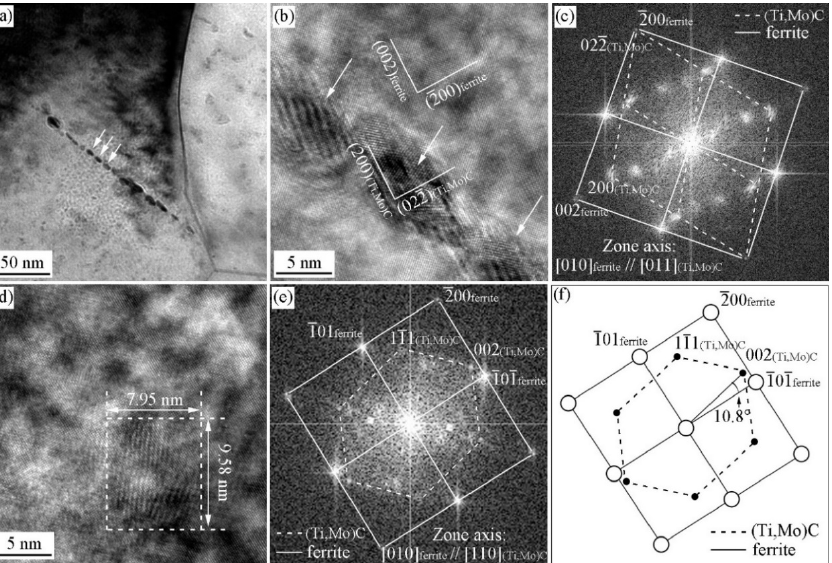
Figure 13. HRTEM image of precipitates and the ORs between the precipitates and ferrite matrix in the Ti-Mo steel produced by process II with the cooling rate of 80 °C/s ( a , b ) TEM and HRTEM im- ages of planer carbides, and the arrow pointing the planer precipitates after grain boundaries mov- ing; ( c ) FFT diffractogram of planer carbides; ( d ) HRTEM image of the supersaturated carbide; ( e ) FFT diffractogram; ( f ) the simulated diffraction pattern of the supersaturated carbide. Figure 14 shows the HRTEM images and the FFT diffractogram of a supersaturated precipitate. The carbide and ferrite matrix doesn’t strictly obey the specific OR (KS or P ORs), and deviates a small angle. The above analysis confirm that the precipitates ob- tained from the Ti-Mo steel with the cooling rate of 80 °C/s after deformation cannot sat- isfy the specific ORs with ferrite matrix for the energy accumulated and maintained in the deformation and fast cooling process, which can be used to offset the formation energy of precipitates. Figure 14. HRTEM image of precipitate and the OR between precipitate and ferrite matrix in Ti-Mo steel produced by process II with the cooling rate of 80 °C/s ( a ) HRTEM image; ( b ) FFT diffracto- gram.